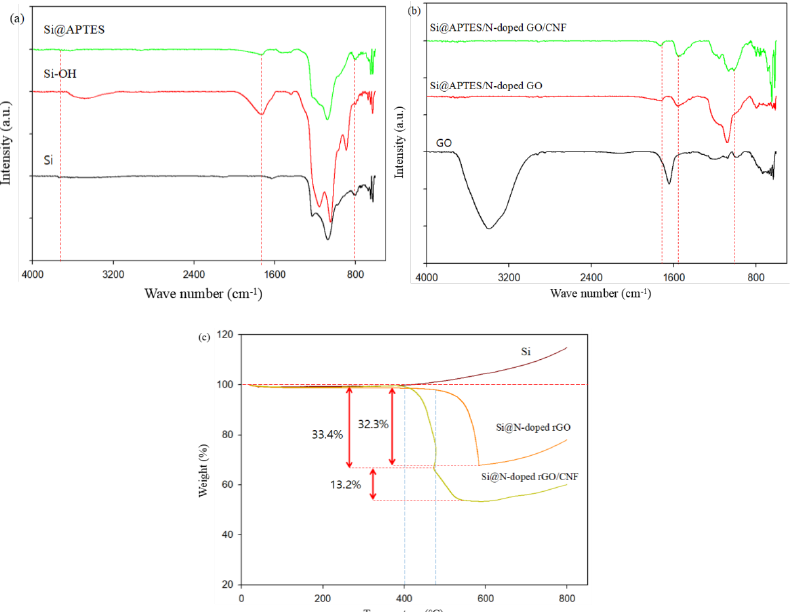
Figure 6. ( a ) Fourier-transform infrared (FTIR) spectra of Si, Si@OH, and Si@APTES, ( b ) Fourier-transform infrared (FTIR) spectra of GO and Si@APTES/N-doped GO and Si@APTES/N-doped GO/CNF, ( c ) TGA curves of the pure nano-Si, Si@N- doped rGO, and Si@N-doped rGO/CNF composite